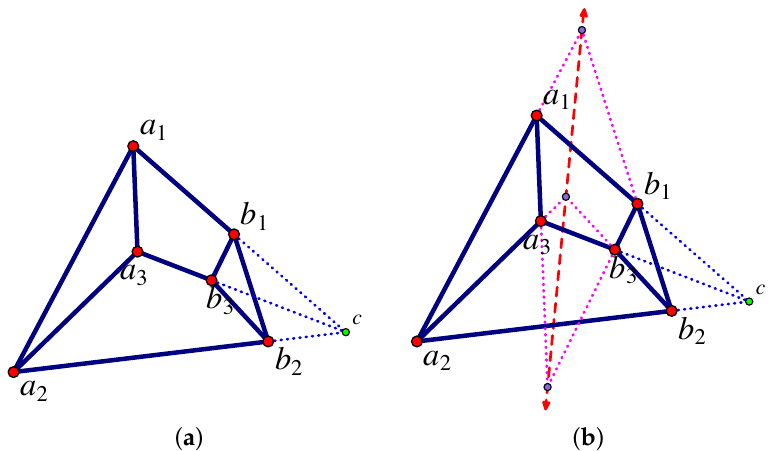
Figure 20. A Desargues configuration with non-collinear triangles is infinitesimally flexible in the plane if and only if the three joining edges are concurrent at a relative center of motion c for the two triangles ( a ), or equivalently, by Desargues Theorem, if and only if the two triangles are perspective from a line ( b ). The three collinear points on the line of perspective are the relative centers of motion of the pairs of opposite edges a i b i , a j b j connecting the